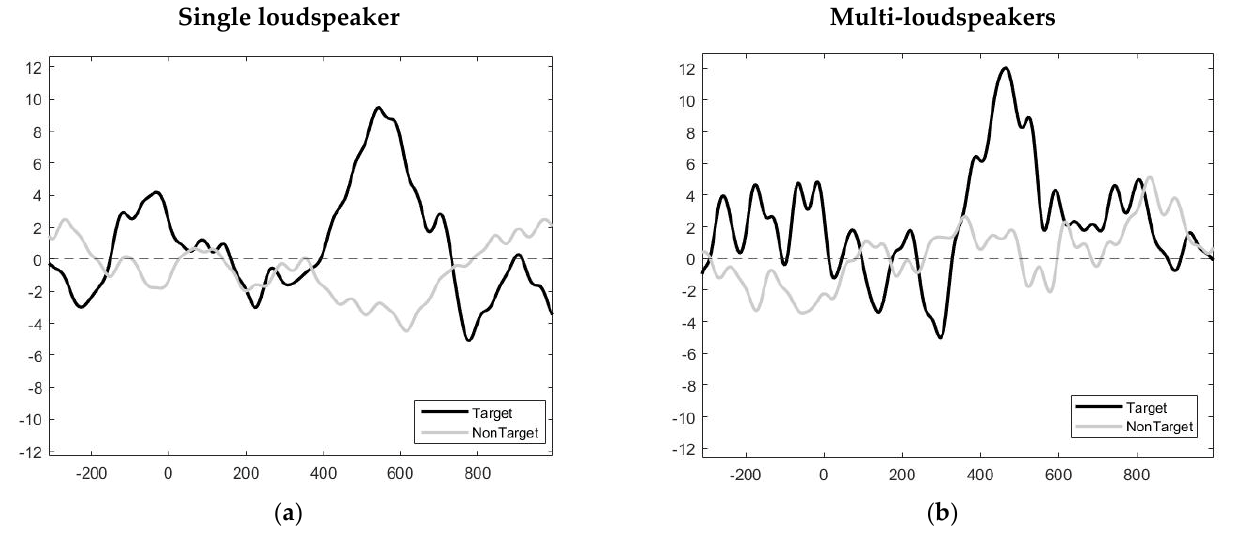
Figure 5. Example of grand − averaged ERPs obtained from all subjects over the auditory stimulus interval 250 ms. ( a ) Grand − averaged ERPs from the auditory stimulus based on the sounds of numerals produced via a single loudspeaker. ( b ) Grand − averaged ERPs from the auditory stimulus based on the sound of numerals produced via multiple loudspeakers.